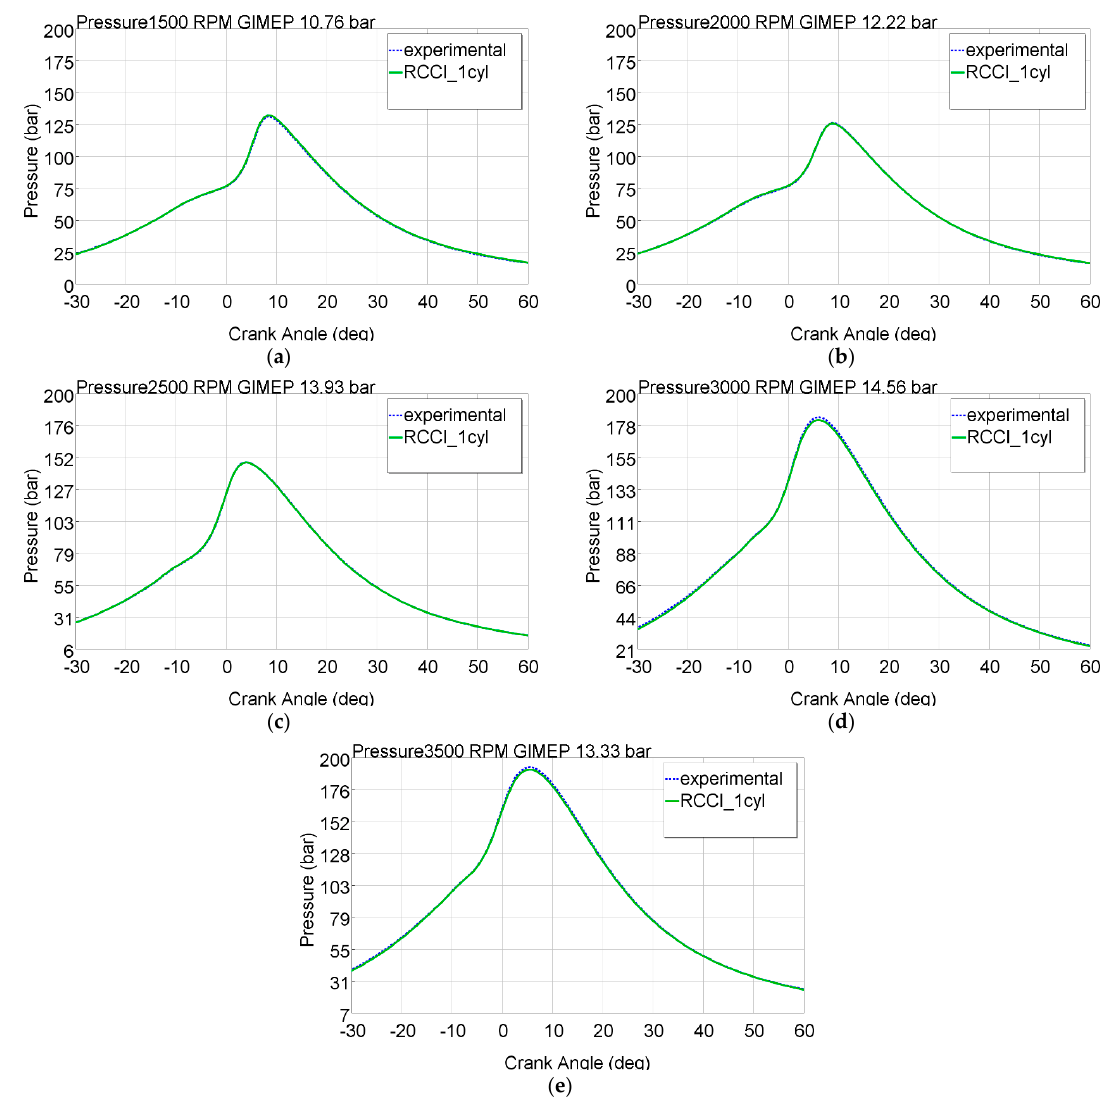
Figure 6. In-cylinder pressure comparison between experimental data and the simulated RCCI single cylinder at full load, speed: ( a )1500 rpm; ( b ) 2000 rpm; ( c ) 2500 rpm; ( d ) 3000 rpm; ( e ) 3500 rpm.